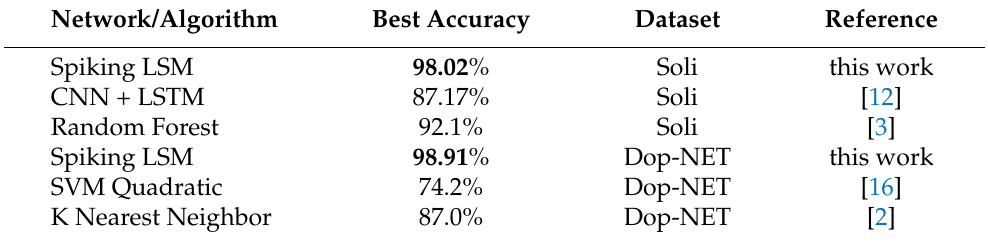
Table 4. State-of-the-art radar-based gesture